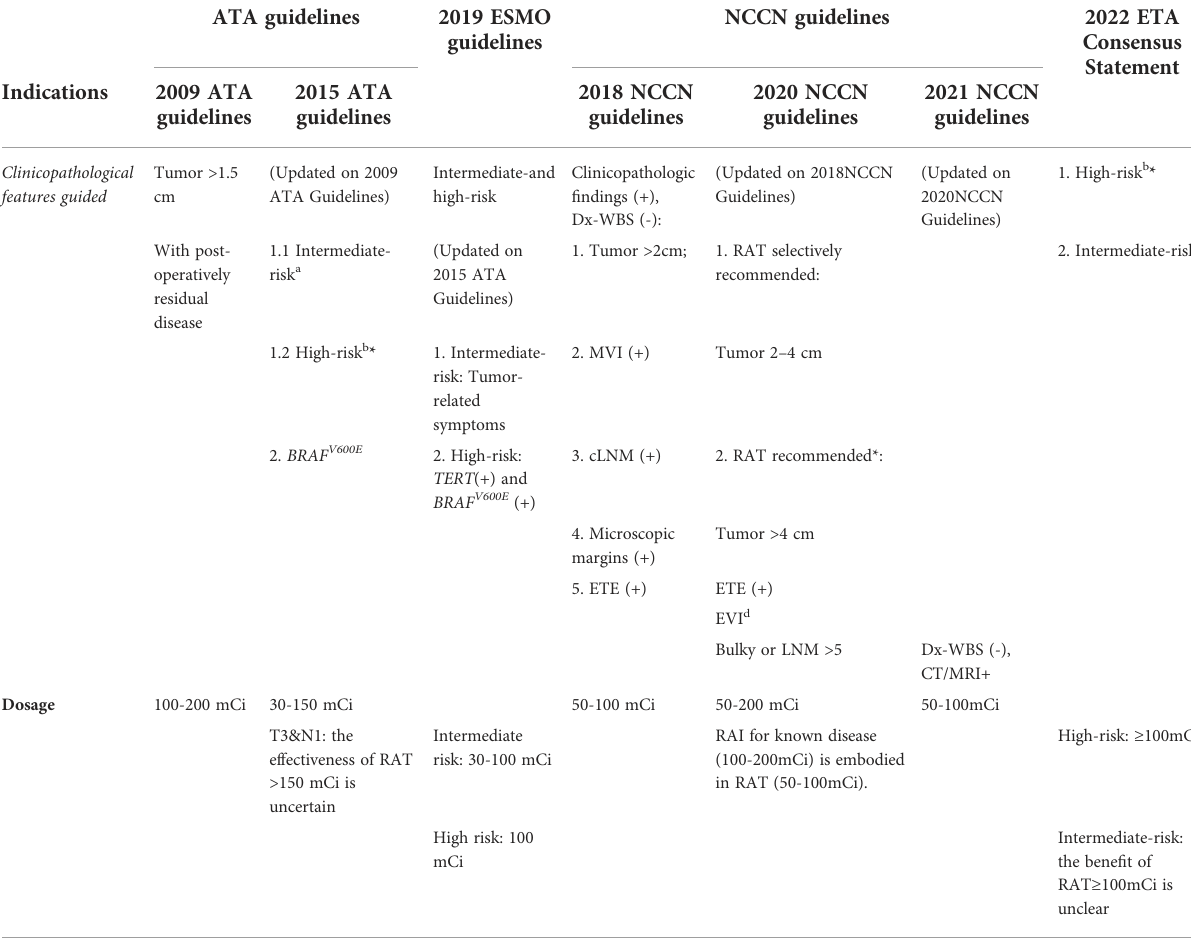
TABLE 2 Evolution of RAT in guidelines by clinicopathological